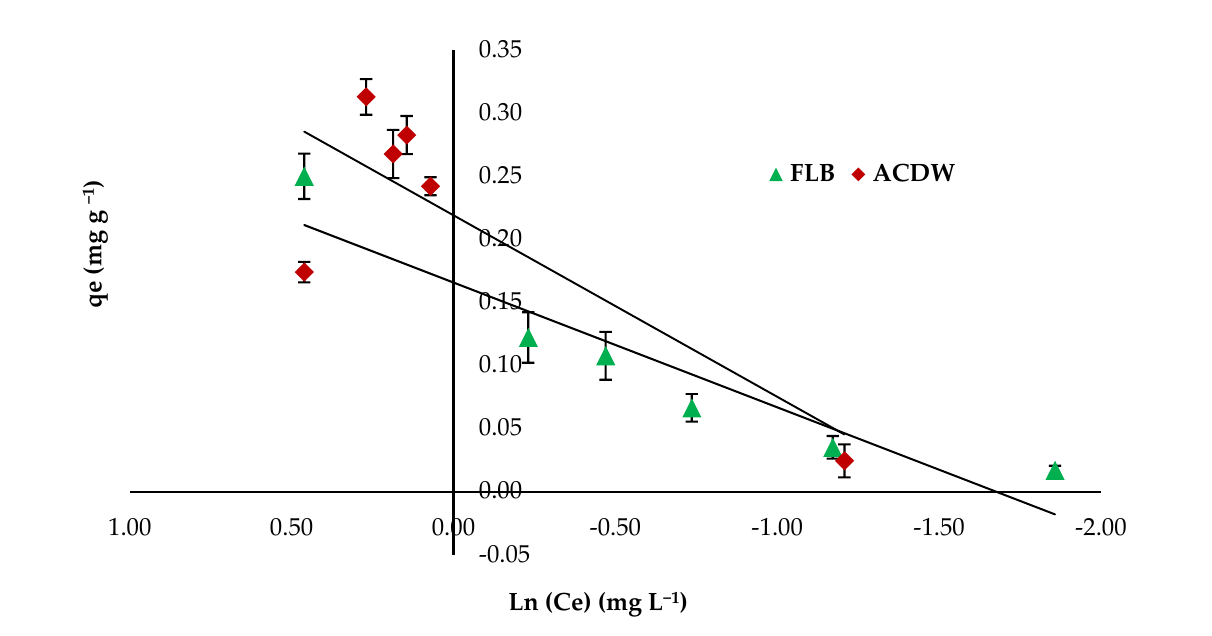
Figure 10. Tempkin isotherm plot for removal efficiency of IV2R dye.